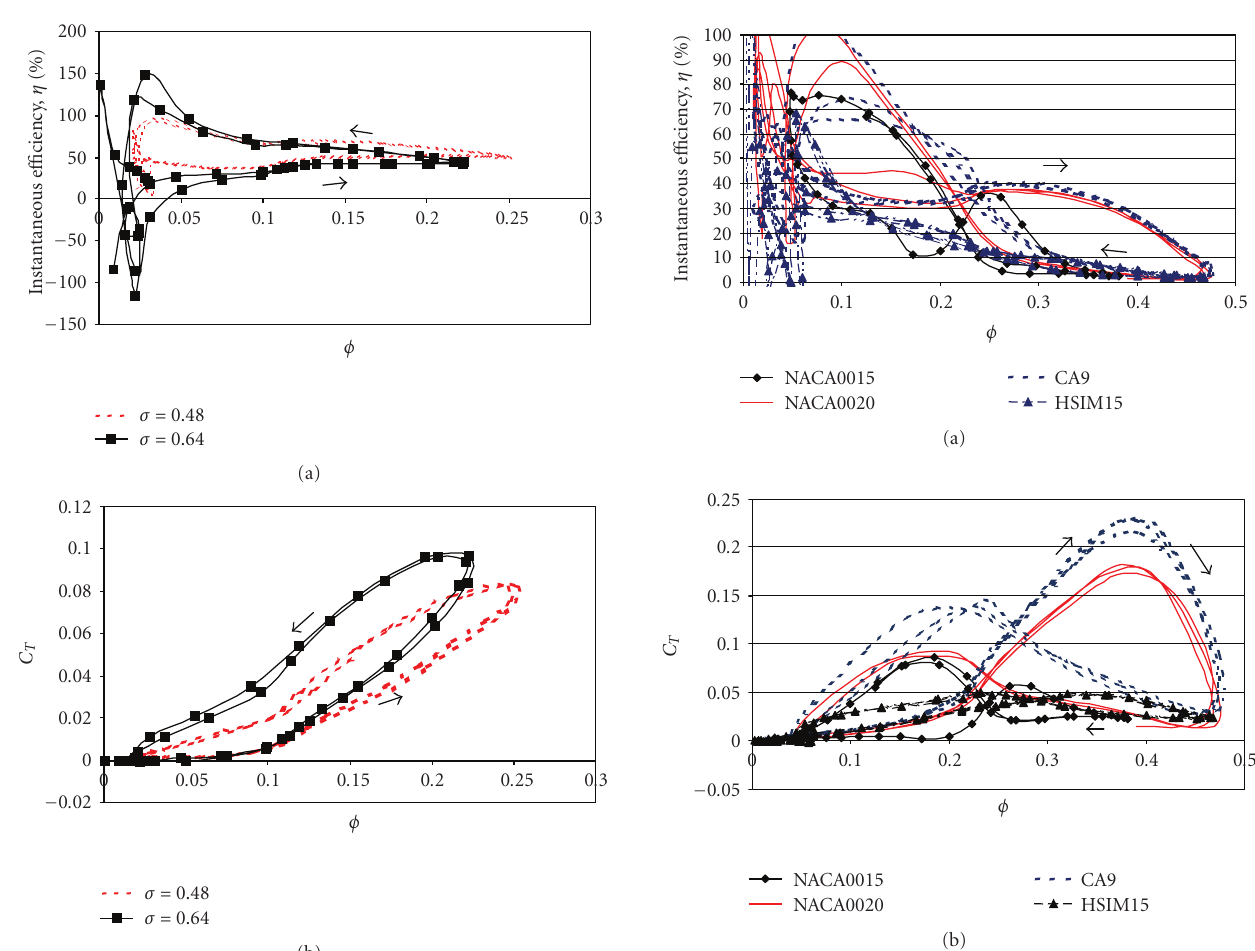
Figure 11: Variations of instantaneous e ffi ciency and torque for dif- ferent blade profile coe ffi cient at 1 /κω ∗ = 0 . 44 ( σ = 0.64): (a) e ffi - ciency, (b) torque coe ffi